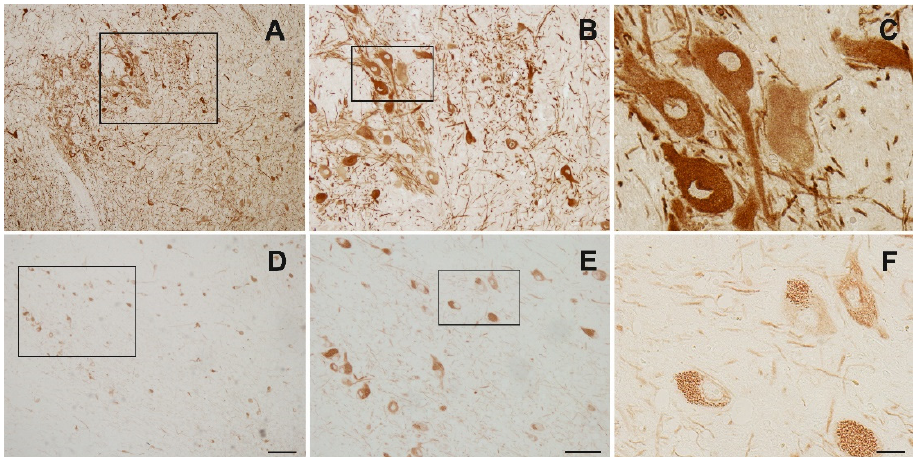
Figure A2. Representative digitalized photomicrographs of the human SNc stained for TH. Note the improved staining quality in the antigen retrieval treated sections ( A – C ) compared to not treated ( D – F ). ( B , E ) are magnifications from the box in ( A , D ), ( C , F ) are magnifications from ( B , E ). Scale bars: 200 µm ( A , D ), 100 µm ( B , E ), 20 µm ( C , F ). Thereafter, slides were blocked for 45 min with 10% horse serum in 0.1% Triton X-100 2.5% horse serum and 0.1% Triton X-100. Following washes in PBS (4 × 15 min) to